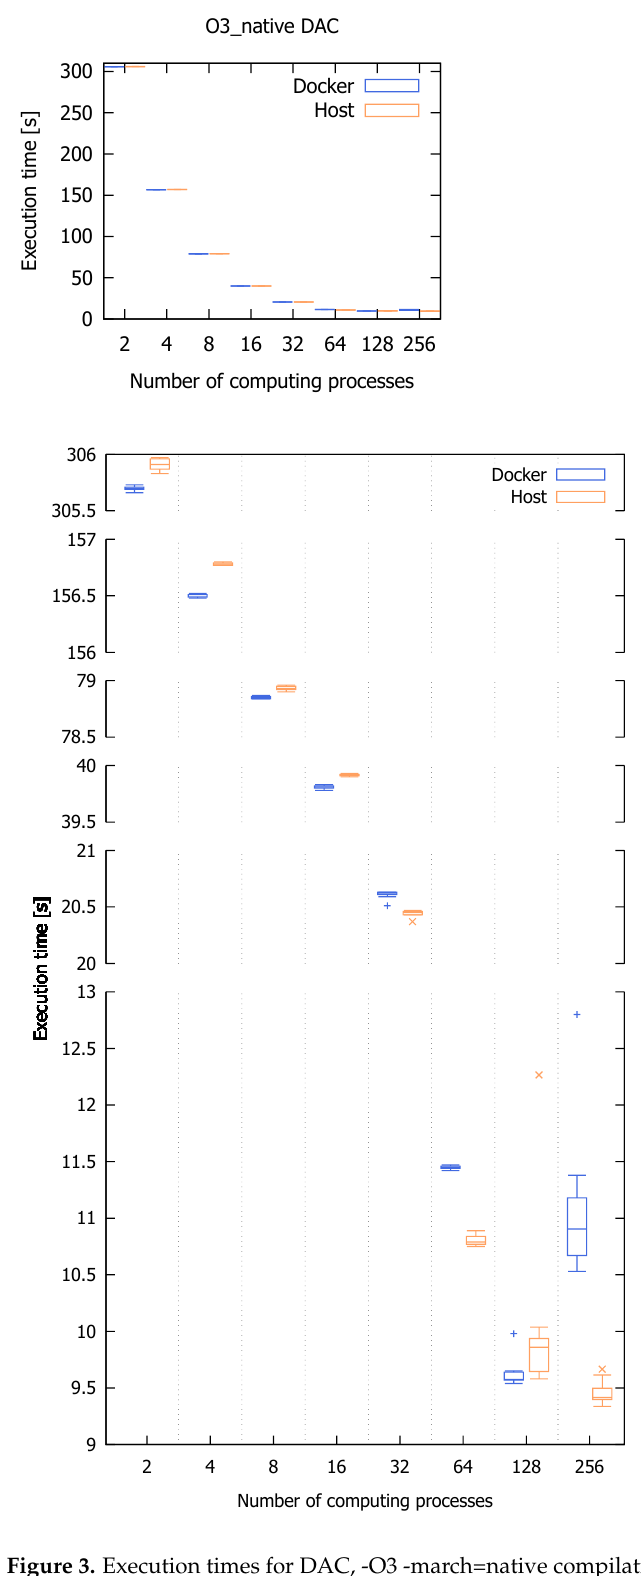
Figure 3. Execution times for DAC, -O3 -march=native compilation flag; boxplot notation: medians, Q1 and Q3, max(Q1 − 1.5IQR, minimum) and min(Q3+1.5IQR, maximum) as well as potential outliers (+ for Docker, x for